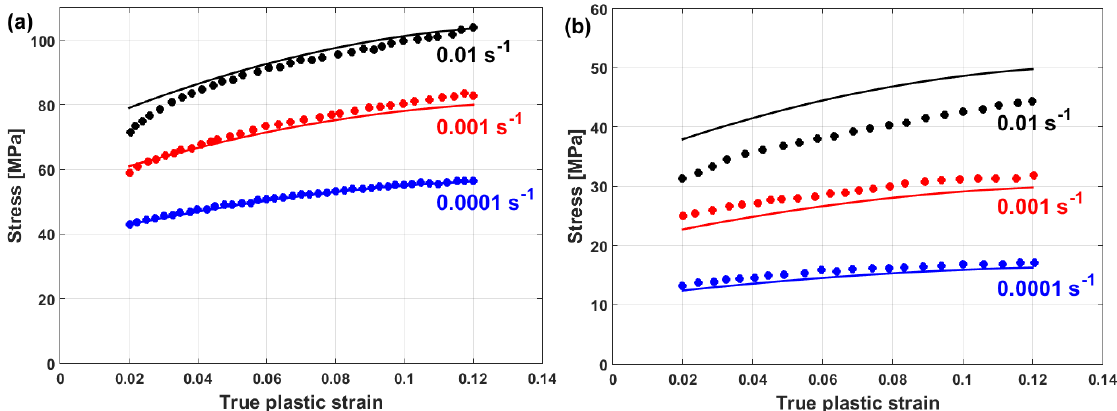
Figure 15. Experimental stresses (markers) compared to predicted stresses (solid lines) obtained by the modified JC model that was presented by Lin et al. [73] for typical high-strength alloy steel at ( a ) 1123 K and ( b ) 1323